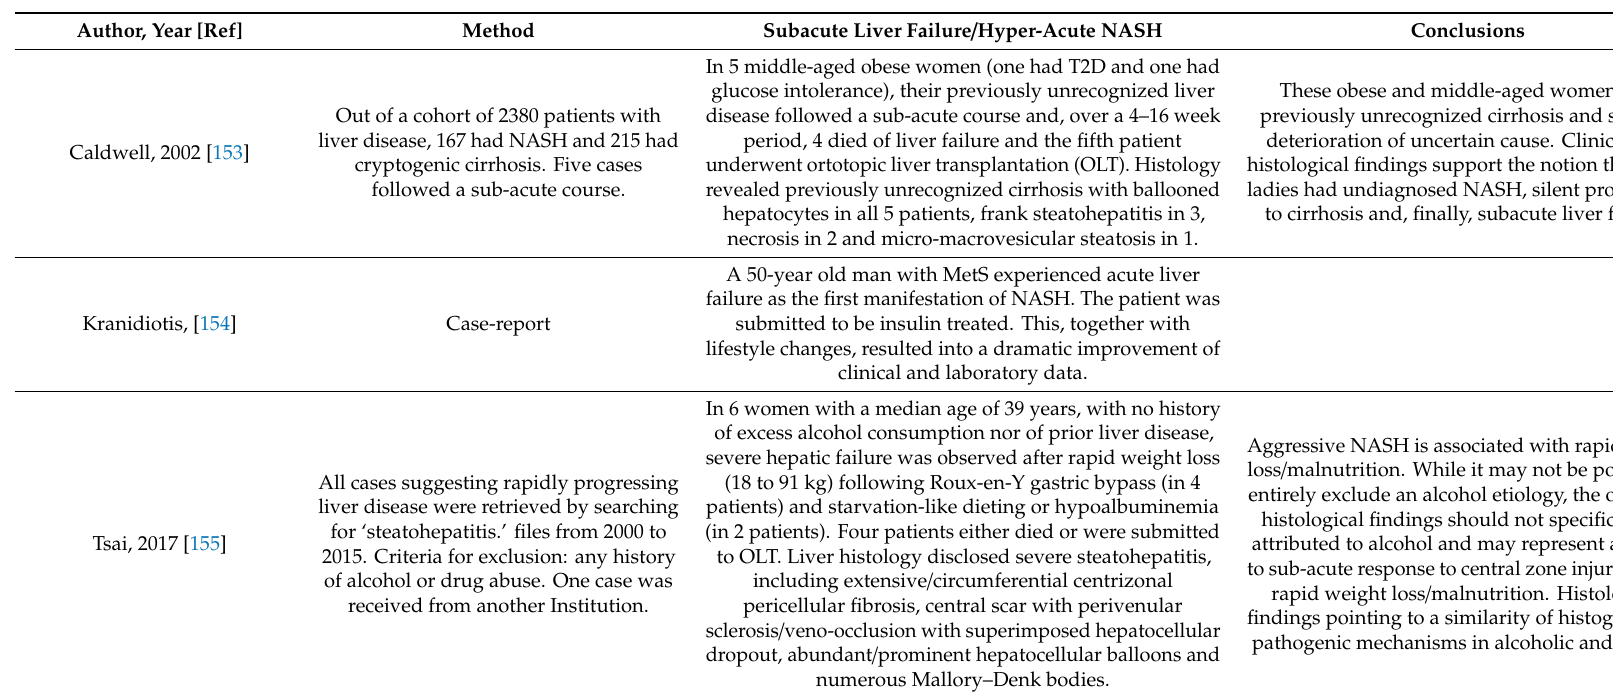
Table 3. Fulminant liver failure and hyper-acute